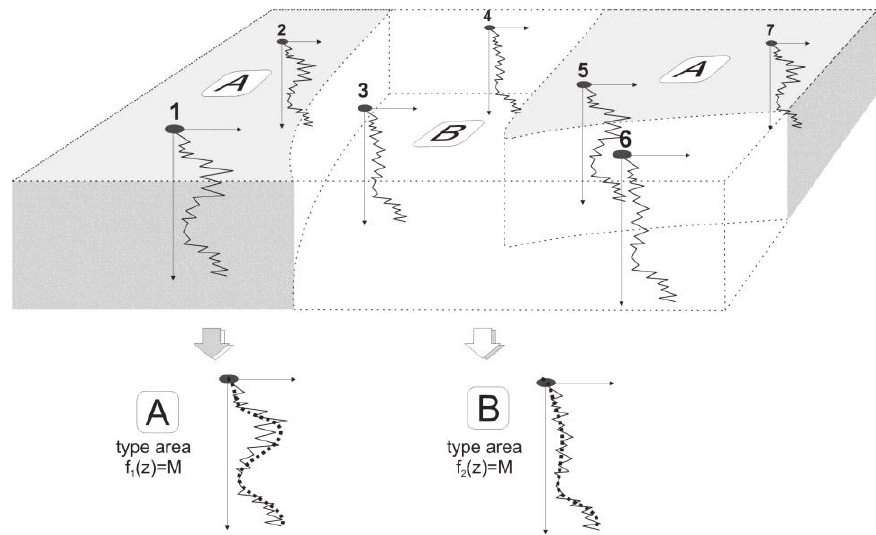
Figure. 1. Location of the test site in Poland. Figure 2. Typical soil and CPTU profile of the test site.